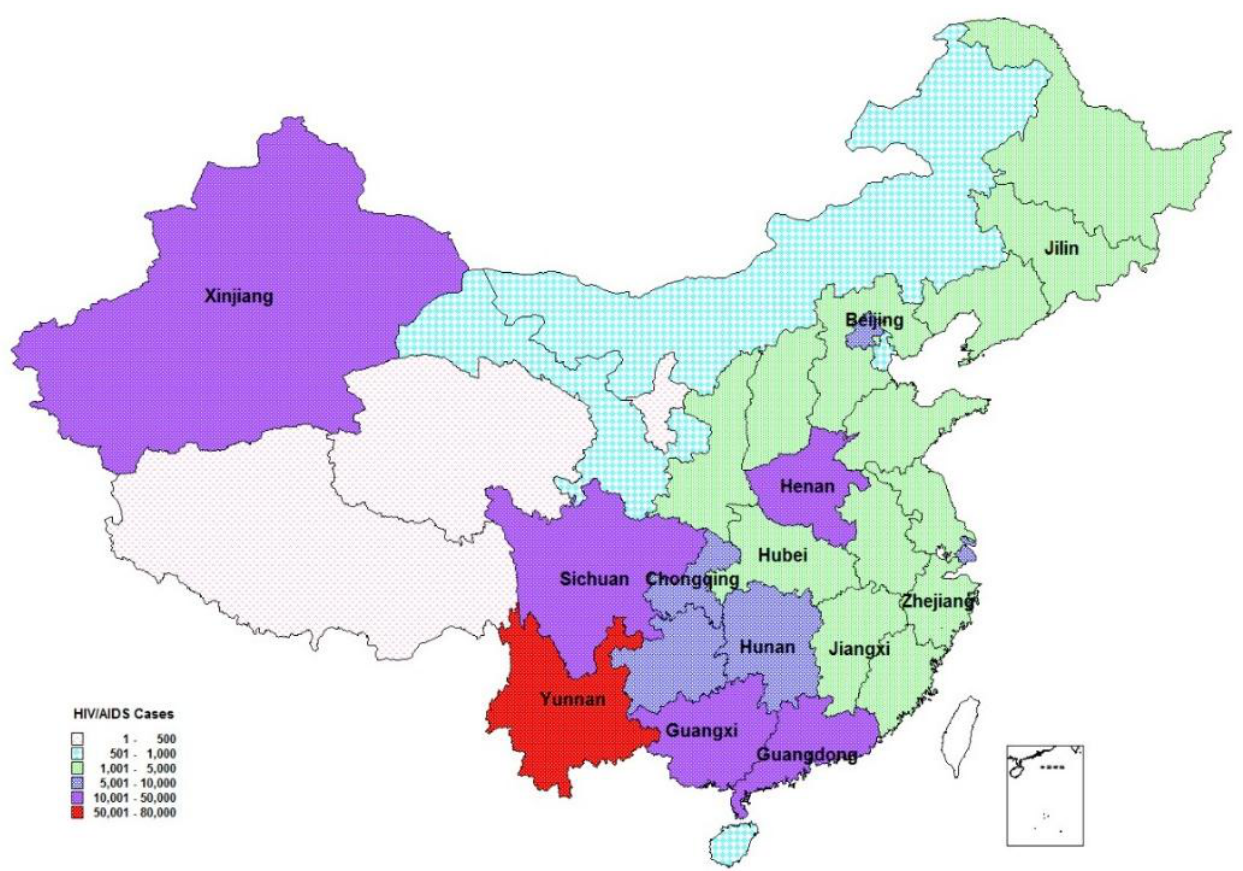
Figure 2. Spatial distribution of reported people living with HIV/AIDS by 2010. Note: Provinces with labels participated this program. All 13 provinces had reported 87.8% of diagnosed people living with HIV/AIDS by the end of 2010). Adapted from